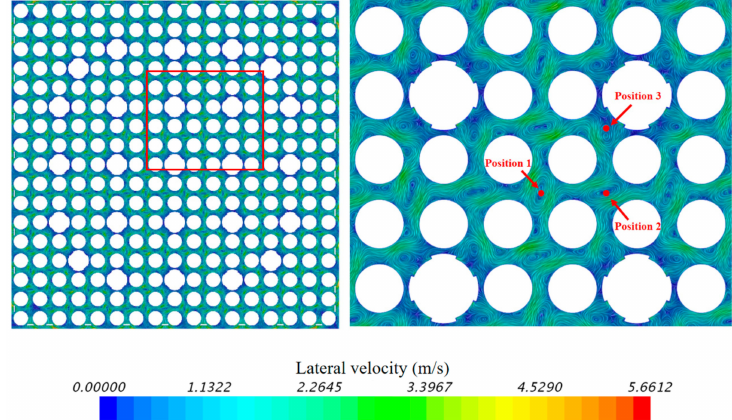
Figure 16. Location of the monitoring points.